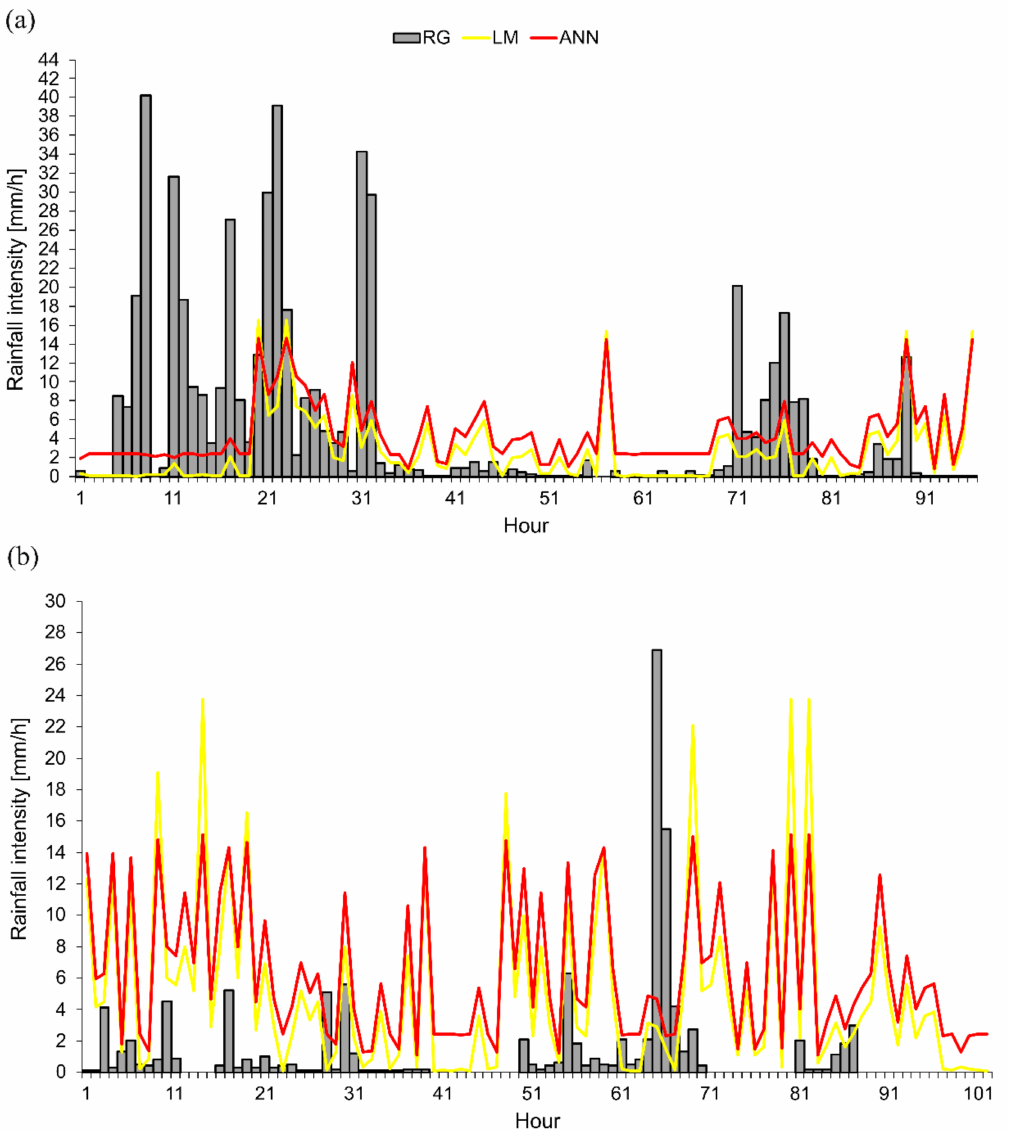
Figure 12. Plot of the rain gauge measurement and estimated rainfall from the radar rainfall on hourly basis for ( a ) 16 to 19 December 2014 (96 h) and ( b ) 20 to 24 December 2014 (102